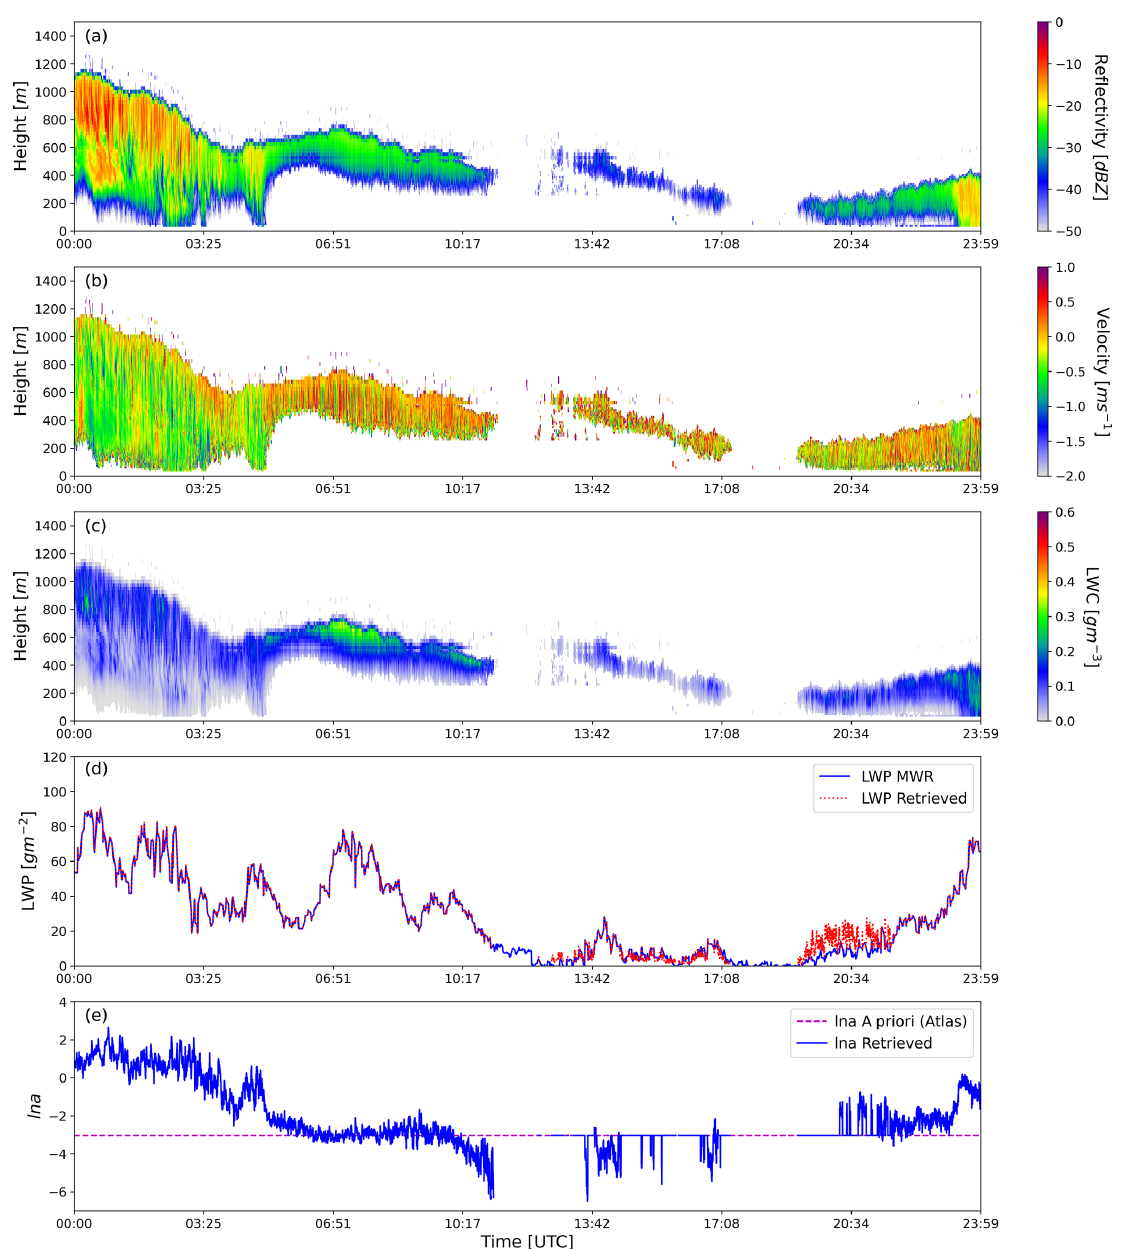
Figure 2. (a) Time–height plot of radar reflectivity; (b) time–height plot of vertical velocity; (c) time–height plot of retrieved LWC; (d) LWP estimated by the radiometer alone through quadratic regression, interpolated at radar time; and (e) retrieved scaling factor ln a of each profile for the 5 February 2019 case at